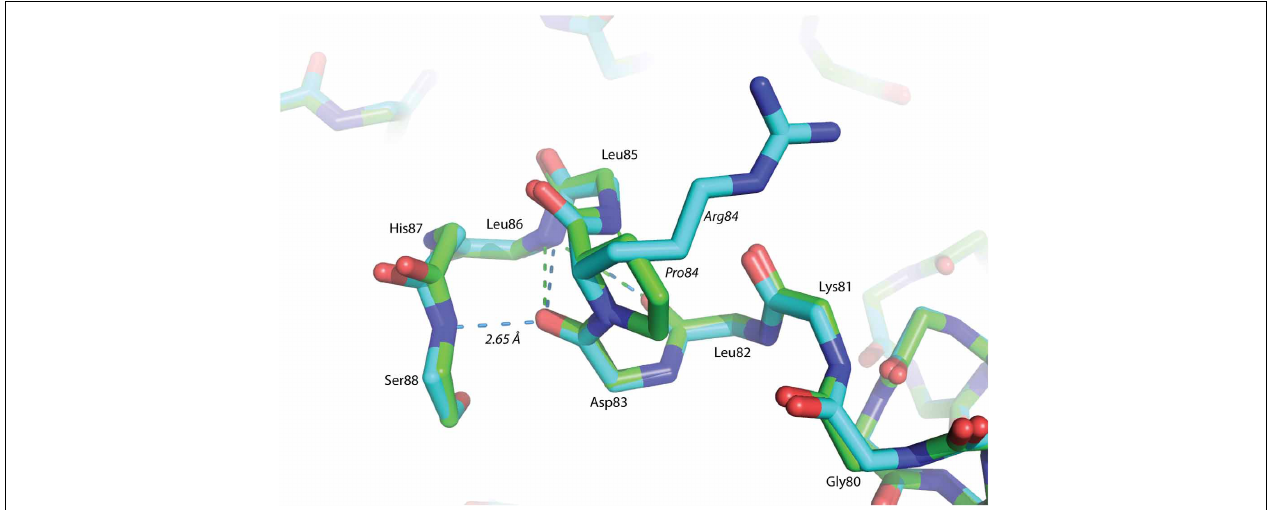
FIGURE 4 | Superposition of helix α -4 from Glutaredoxin A. The green structure is wild-type, while the blue structure is mutant P84R. The dashed-lines are backbone H-bonds that stabilize α -helix 4. One additional consensus H-bond has been included in the P84R